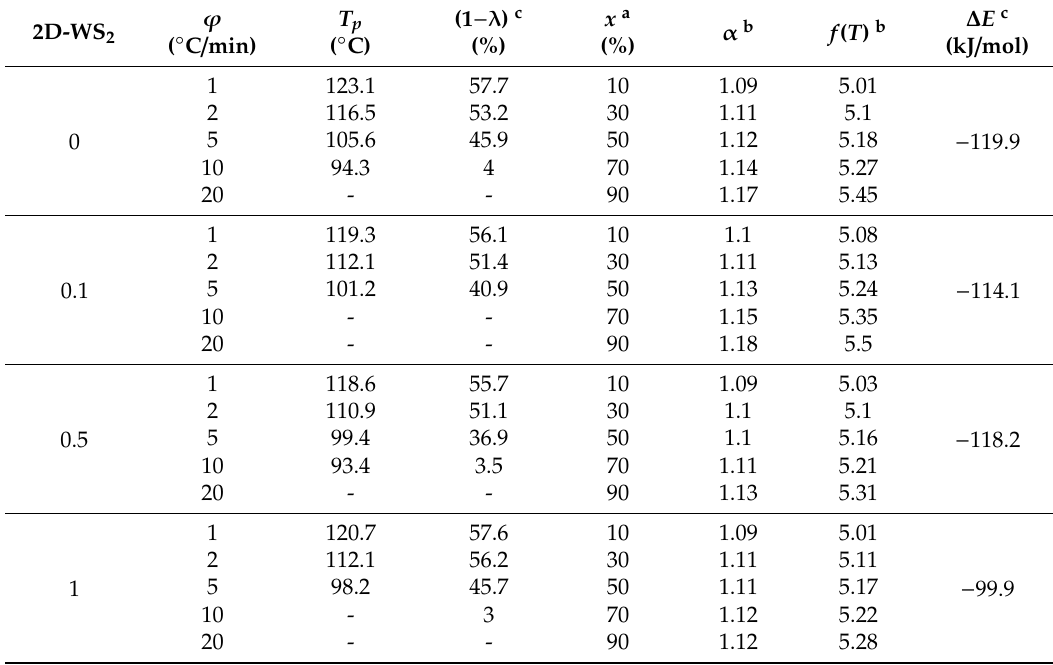
Figure 3. Differential Scanning Calorimetry (DSC) melt-crystallization thermograms of ( a ) PLLA and PLLA/2D-WS 2 nanocomposites with nanofiller loadings of ( b ) 0.1, ( c ) 0.5, and ( d ) 1.0 wt % obtained at the cooling rates indicated. Table 1. Crystallization parameters of the PLLA/2D-WS 2 nanocomposites.